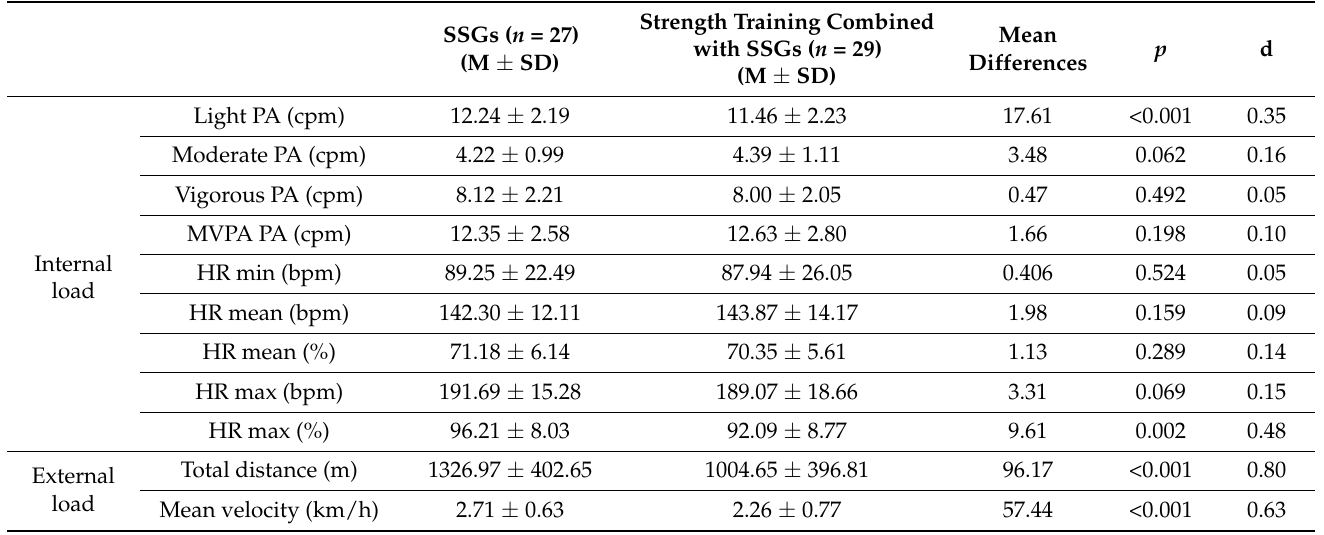
Mean p Differences